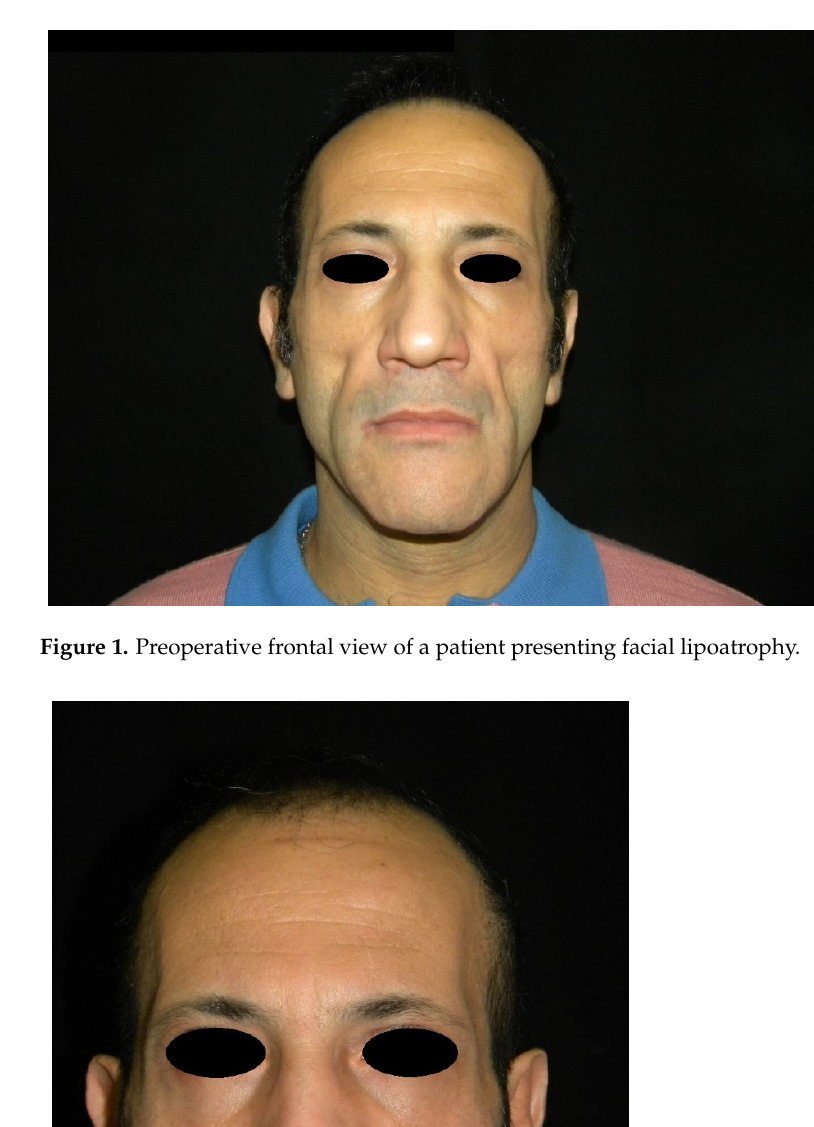
Figure 3. Frontal view of a patient presenting facial wasting (the same patient shown in Figure 1) treated with polyacrylamide hydrogel filler, at 2 years follow-up. Facial rehabilitation was performed in one or more sessions of injections; each patient received the amount of product needed for full rehabilitation according to the patient’s wishes in one or more sessions. Patients injected with polyacrylamide hydrogel were rehabilitated in 2.4 sessions on average. When CaHA or HA were injected, a lower number